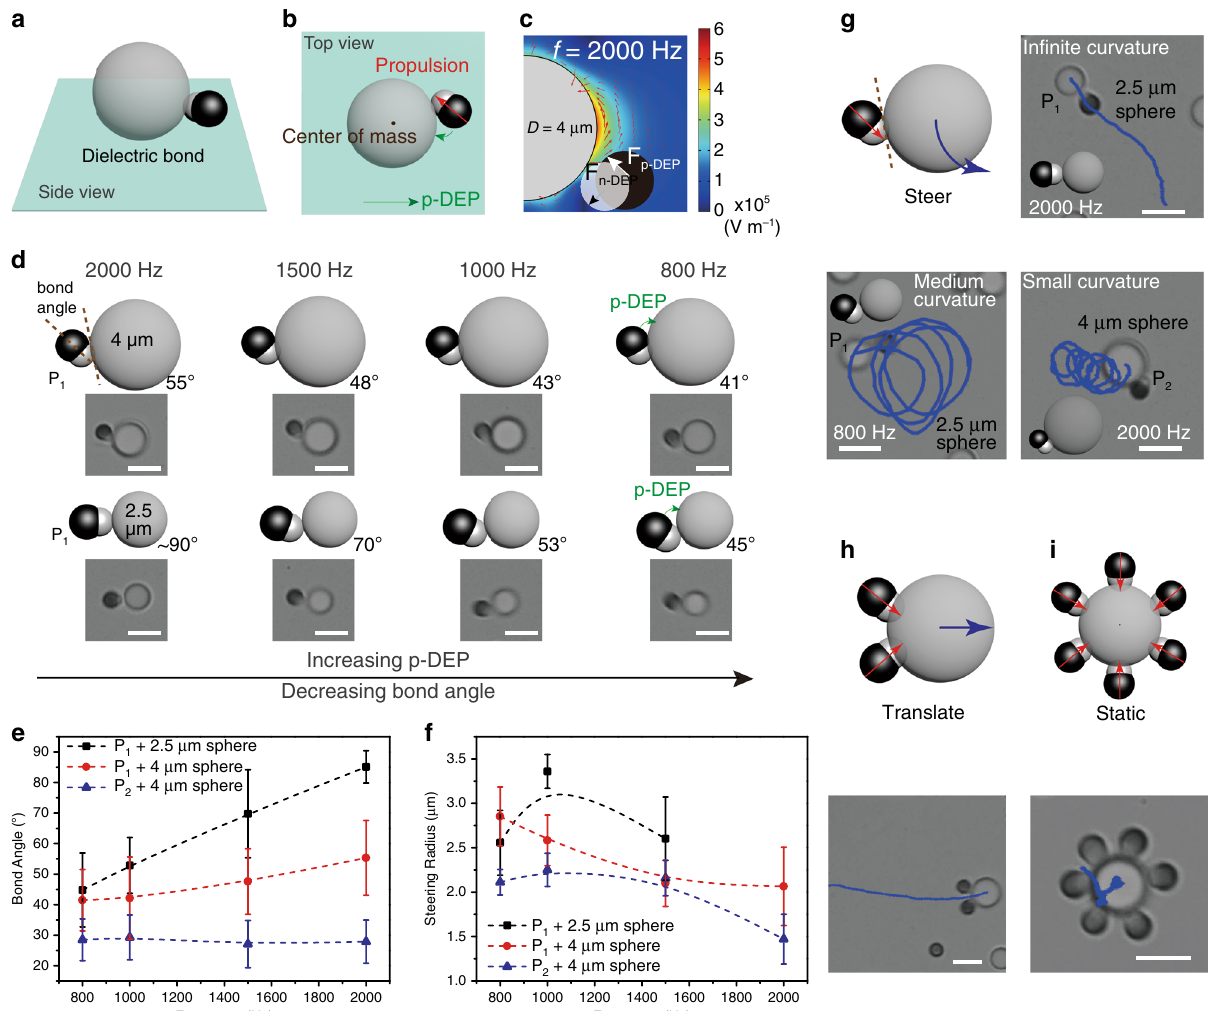
Fig. 3 Colloidal molecules with dielectric bonds. a and b Cartoon showing the side and top view of an AB colloidal molecule featuring the dielectric bond, formed by a metallodielectric patchy particle P 1 and the central dielectric sphere ( D = 4 µ m). The bond angle is de fi ned as the angle between the tangent of where particles touch and long axis of the patchy particle (in x – y plane). c Finite-element analysis showing that the bonding is favorable due to n-DEP attraction for the dielectric lobe ( x – z plane), assisted by p-DEP from the metallic lobe. Red arrows represent the direction of electric fi eld lines. Color bar: electric fi eld strength. d The bond angle decreases when reducing the AC frequency which increases p-DEP. e AC frequency-dependence of bond angles for colloidal molecules assembled by patchy particles P 1 , P 2 , and 2.5-/4- µ m central spheres as labeled. f The radii of steering of the colloidal molecules are determined by their bond angle and the propulsion velocity of the constituent patchy particle, both adjustable by AC frequency (labels are the same as in e ). g Schematic and optical microscope images showing the steering trajectories of colloidal molecules. A wide range of curvature (in fi nite, medium, and small) are achieved. h Colloidal molecule shows translational trajectory when more ligand patchy particles join the assembly (AB n , n ≥ 2). i The saturated colloidal molecules are somewhat static due to balanced forces. Scale bar: 4 μ m. The error bars refer to the standard deviation of values for multiple As patchy particles within an assembly maintain the propensity to swim (the direction labeled by small red arrow in Fig. 3), the colloidal molecules show intriguing dynamics. When the bond angle is 90°, the assembly follows a pure translational motion (i.e., (Fig. 3g). In a more typical case where the bond angle is smaller pass the mass center of the central sphere, therefore leading to determined by the bond angle as well as the velocity of the patchy